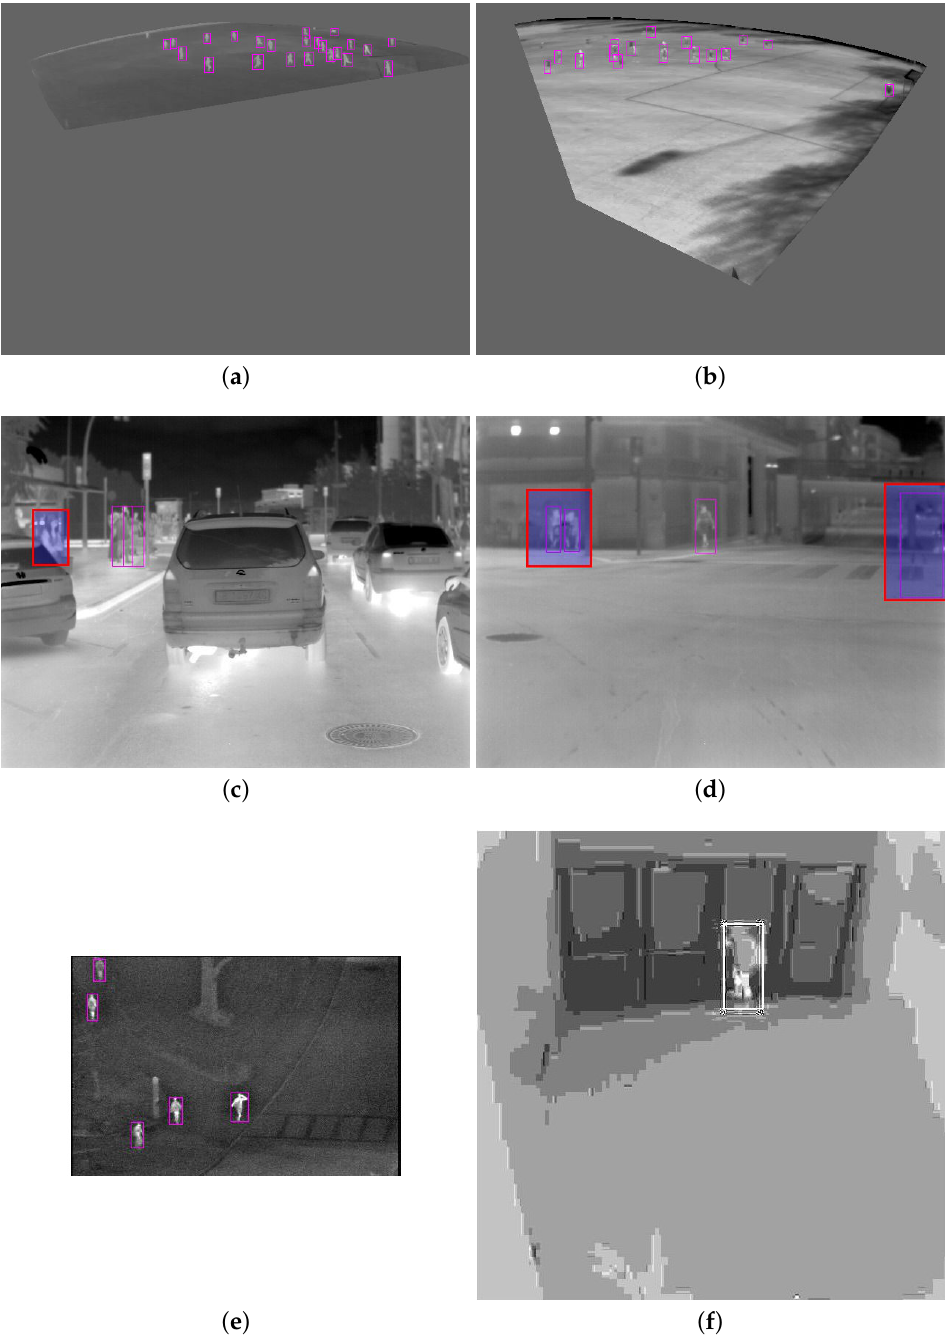
Figure 6. Example images for qualitative assessment. The images ( a ) and ( b ) are from our test data. The results of images ( a , b ) are obtained from Combination 16, shown in Table 4. Image ( c ) is from CVC-day [26], image ( d ) from CVC-night [26], image ( e ) from OSU-T [18], and image ( f ) from BU-TIV-atrium [46]. The contrast of ( f ) is adjusted for better visualization. In these images, highlighted red boxes are wrong